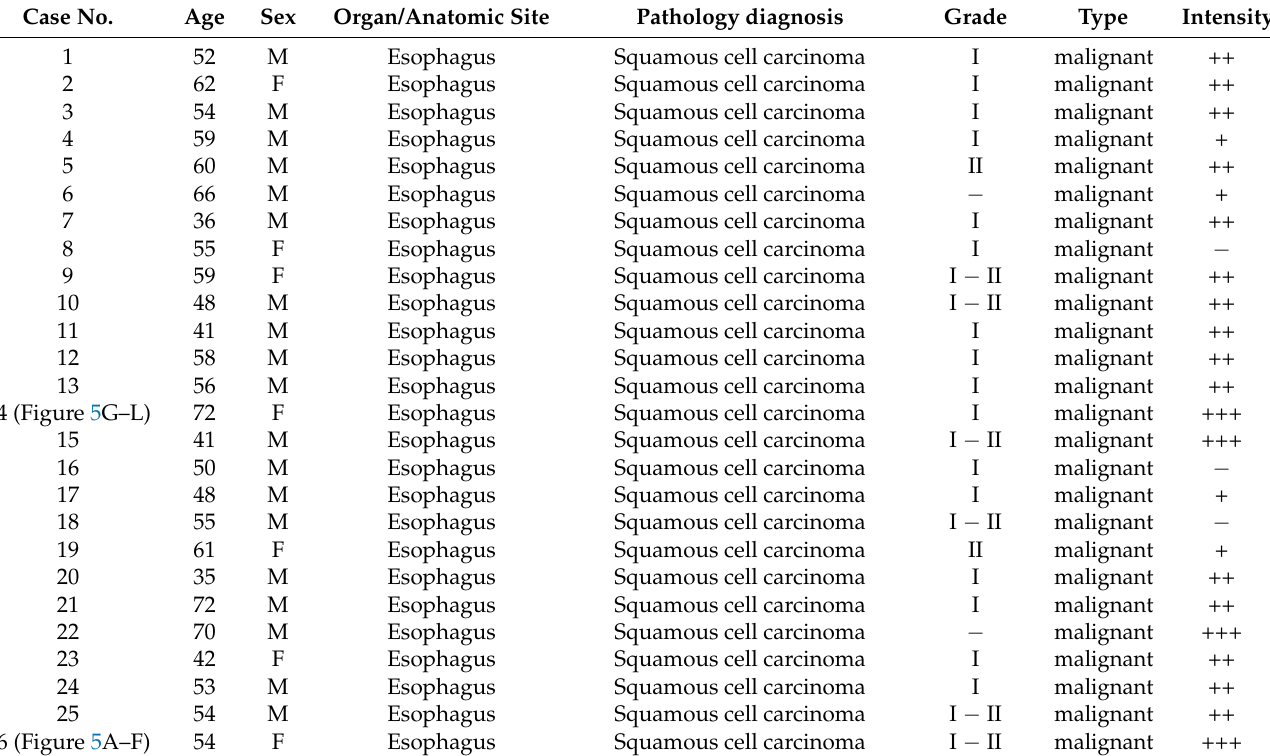
Table 1. Immunohistochemical analysis using C 44 Mab − 46 against ESCC